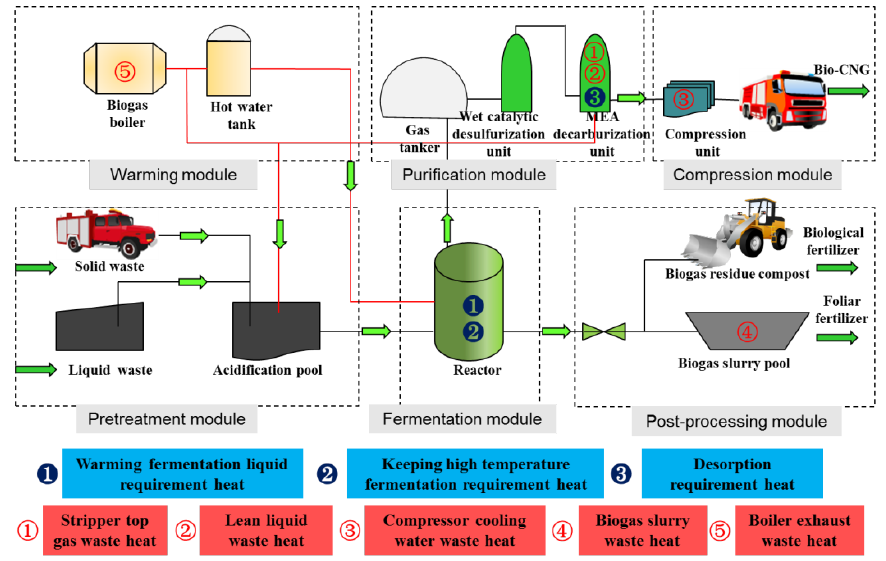
Figure 1. Systemic flow diagram of the vehicle bio-methane plant.